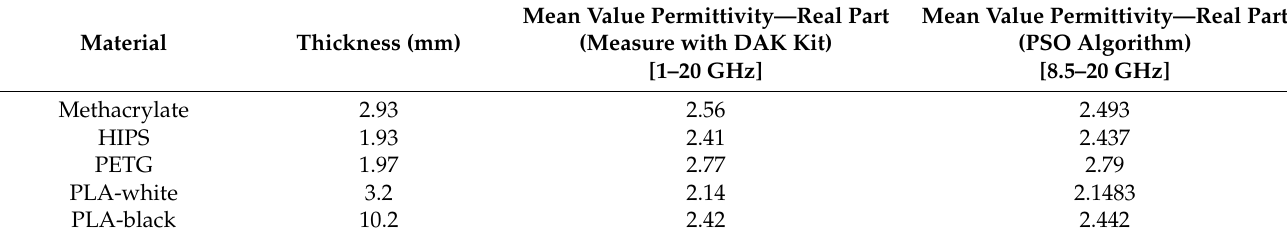
Table 3. Methacrylate, HIPS, PETG and PLA samples properties.